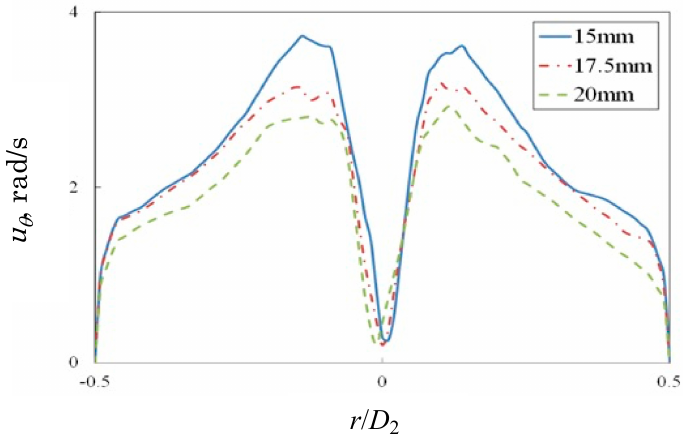
Figure 8. Rotational angular velocity of the central section.